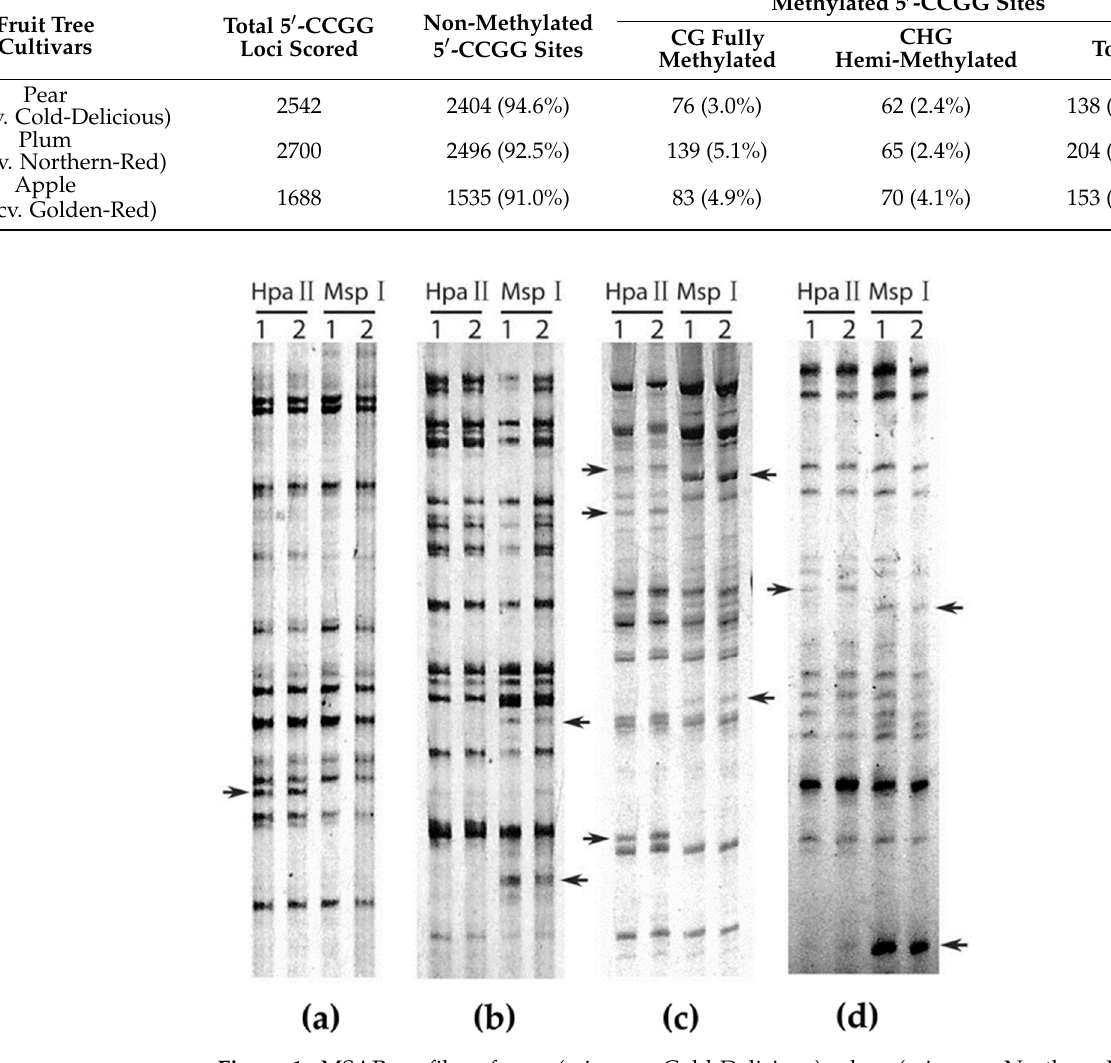
Figure 1. MSAP profiles of pear (scion cv. Cold-Delicious), plum (scion cv. Northern-Red) and apple (scion cv. Golden-Red) trees. The primer combinations used were E-AGC/H/M-TGA in panel ( a ) (pear), E-AGC/H/M-TTA in panel ( b ) (pear), E-ATC/H/M-TGT in panel ( c ) (plum) and E-AAC/H/M-TTA in panel ( d ) (apple). HpaII and MspI referred to digestion with EcoRI+HpaII and EcoRI+MspI , respectively. Methylated bands at either the inner (absence from H but present in M) or the outer (absence from M but present in H) cytosines of the 5′-CCGG sites were denoted by arrows. The assay was independently performed twice, and all marked bands were reproducible.